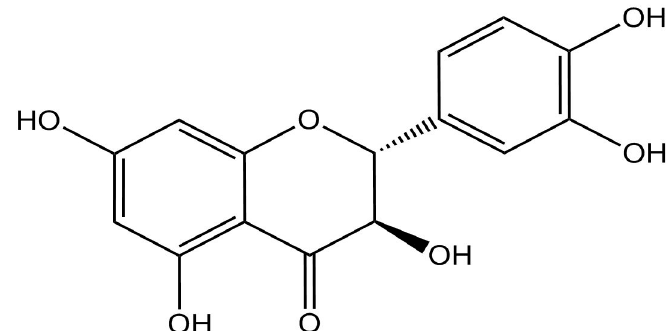
Figure 1. Chemical structure of TAX.